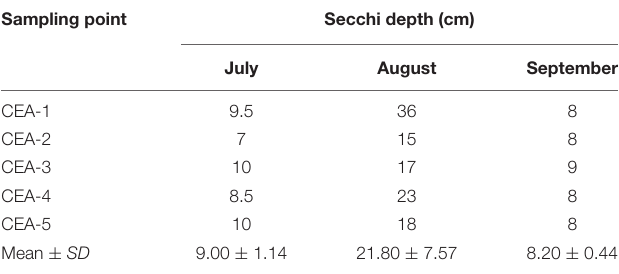
TABLE 1 | Secchi depth by month and sampling site. Sampling point